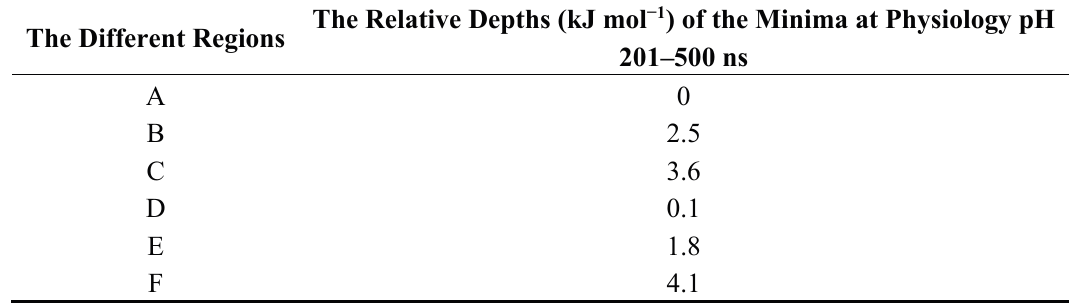
Table 2. The relative depths of the free energy minima of the α -syn12 dimer at the acidic pH. The Different